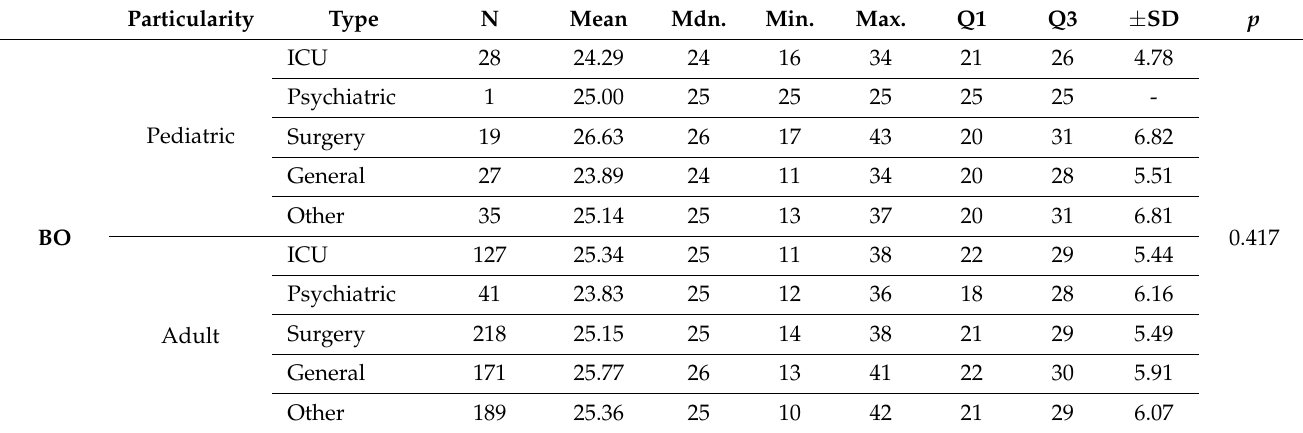
Table 2. The level of burnout by the particularity and type of work department.